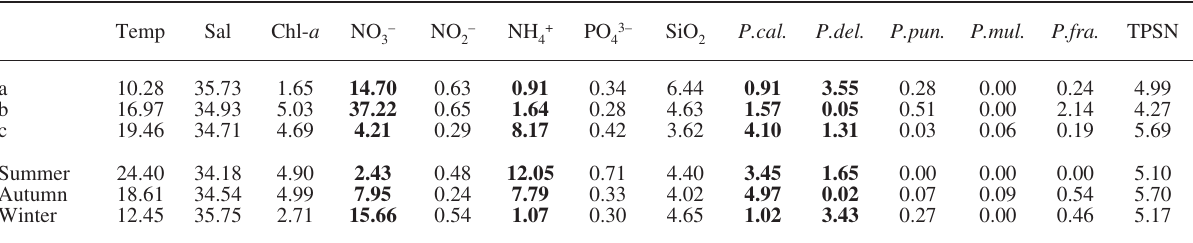
Table 3. – Mean values (n = 28) for abiotic and biotic parameters of alfacs Bay with respect to cluster group ( a , b and c ) (see text) and season (summer, autumn and winter). temperature (temp), salinity (Sal), chlorophyll a concentration (chl- a , µg l -1 ), dissolved inorganic nutrients (µM), Pseudo-nitzschia abundance per species (cells l -1 ), and total Pseudo-nitzschia abundance (tpSn). variables with a significant role defining these groups are indicated in bold. P.cal., P.calliantha ; P.del., P. delicatissima ; P.pun., P. pungens ; P.mul., P. multistriata ; P.fra.,